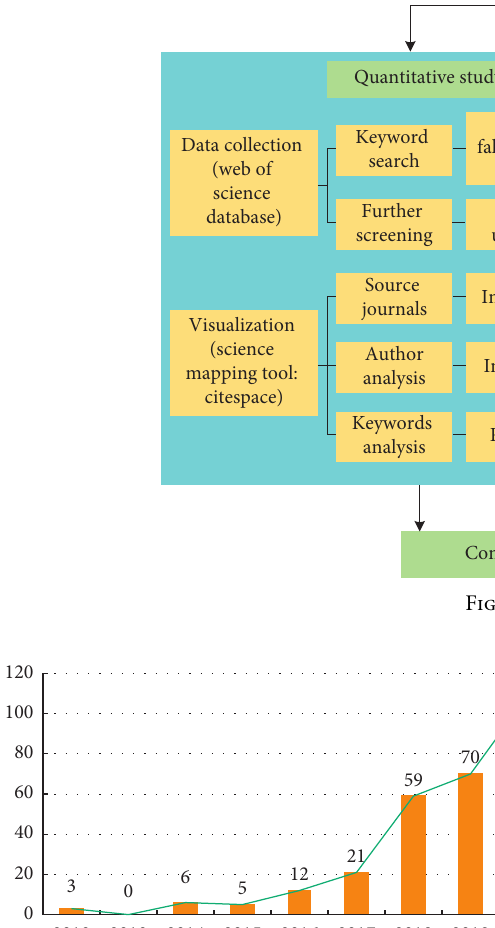
Figure 2: Literature sample in terms of the year of publication from